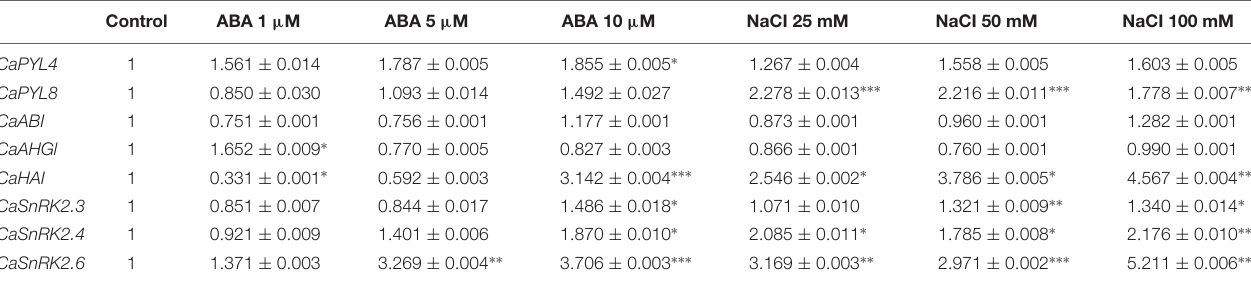
TABLE 1 | Relative quantification of gene expression measured by qRT-PCR of selected genes in seeds of Quadrato D’Asti giallo incubated for 4 days on control medium and media with different concentrations of ABA or NaCl.